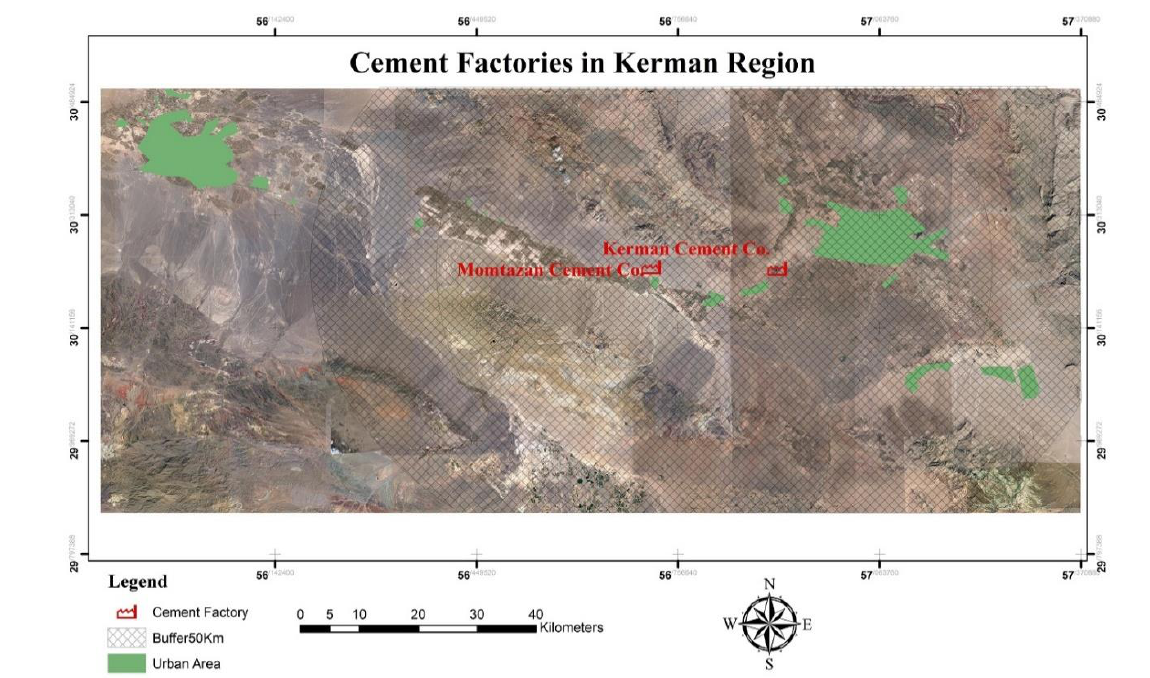
Figure 1 . The Studied Location by 50 Kilometres